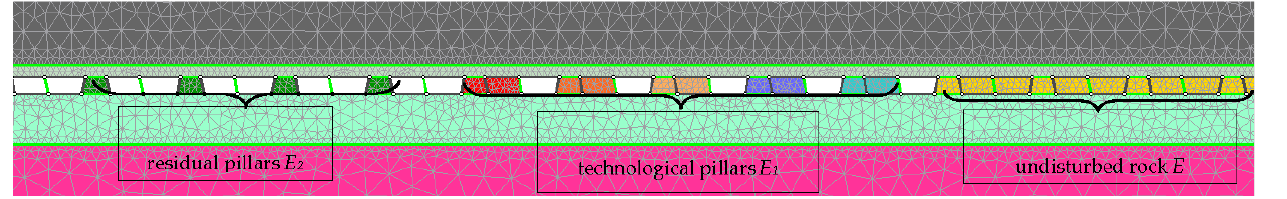
Figure 11. Fragment of the model of analyzed mining field with marked division of pillars.